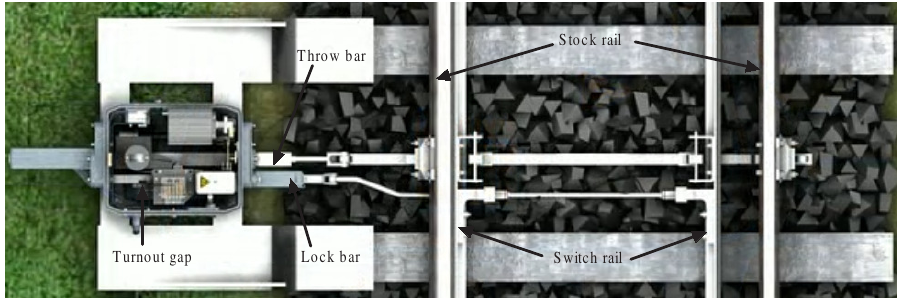
Figure 1. An example of a point